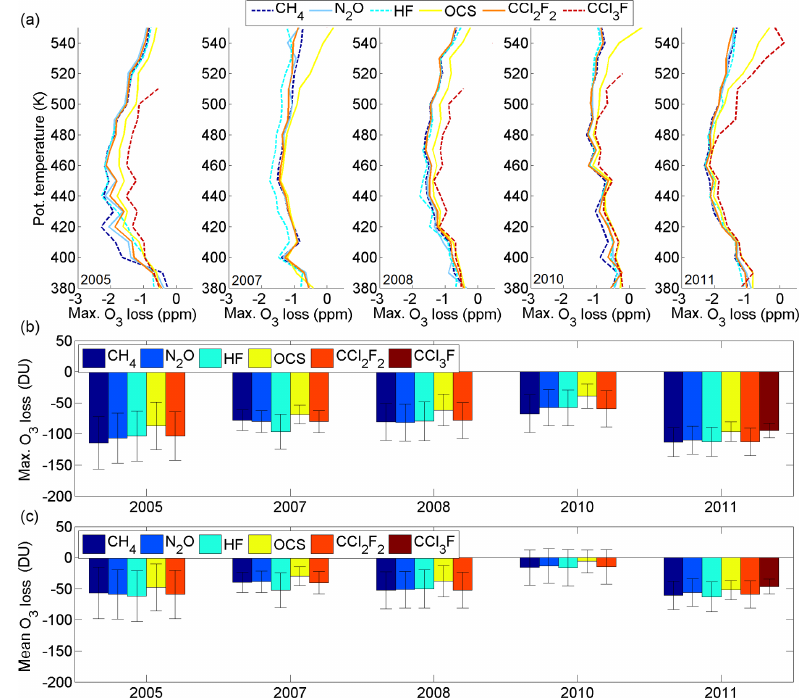
Figure 6. The ozone loss estimates are shown using the tracer-tracer correlation technique. Six different tracers have been employed for this method: CH 4 (blue), N 2 O (light blue), HF (cyan), OCS (yellow), CCl 2 F 2 (orange), and CCl 3 F (dark red). The maximum ozone loss profile (in ppmv) is shown in (a) . For clarity, the uncertainties of the estimated ozone loss profiles have been removed. The integrated ozone loss (in DU) between 380–550K is shown in (b) and (c) for the maximum and mean loss in March,